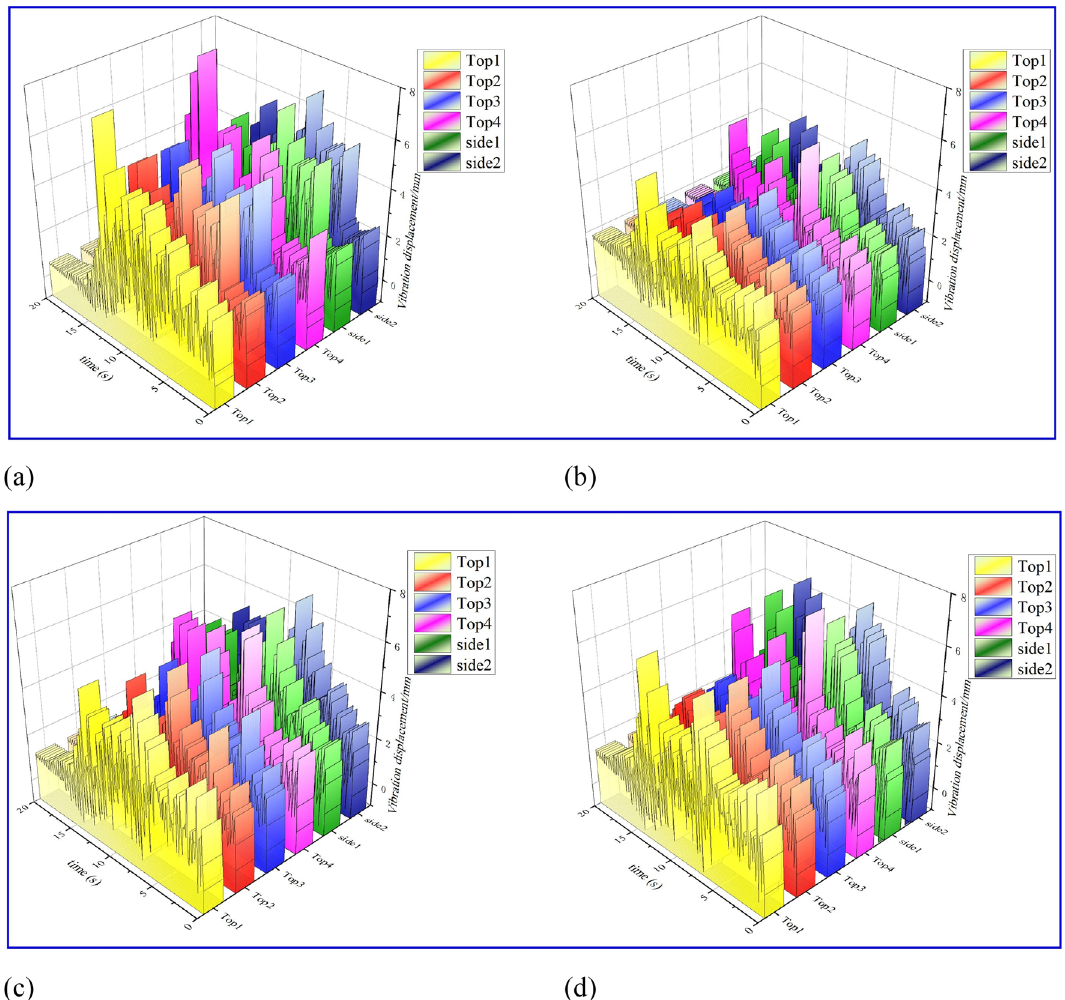
Figure 9. Vibration displacement response diagram of each drilling unit module: ( a ) vibration displacement diagram of drill pipe of different rigs; ( b ) vibration displacement diagram of different drill support plates; ( c ) vibration displacement diagram of power heads of different rigs; ( d ) vibration displacement diagram of different drilling